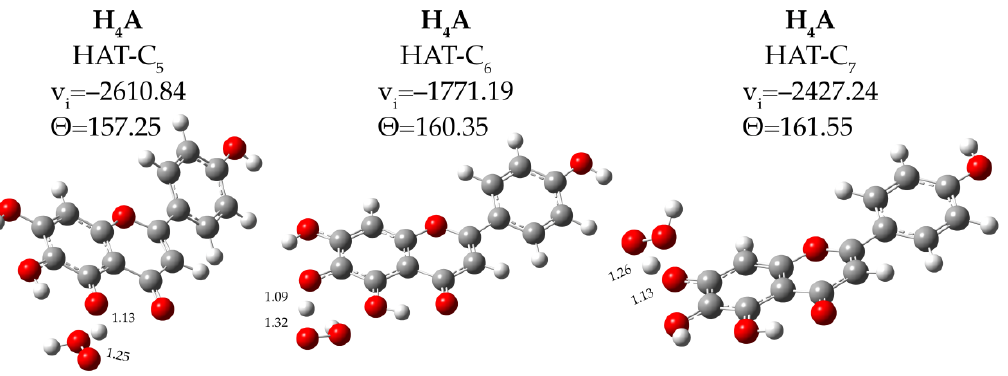
Figure 3. Optimized TS structures with the main geometrical features for the scutellarein in pentylethanoate solvent. Bond lengths in Å, angles ( Θ ) in degrees and imaginary frequencies ( ν ) in cm − 1 .